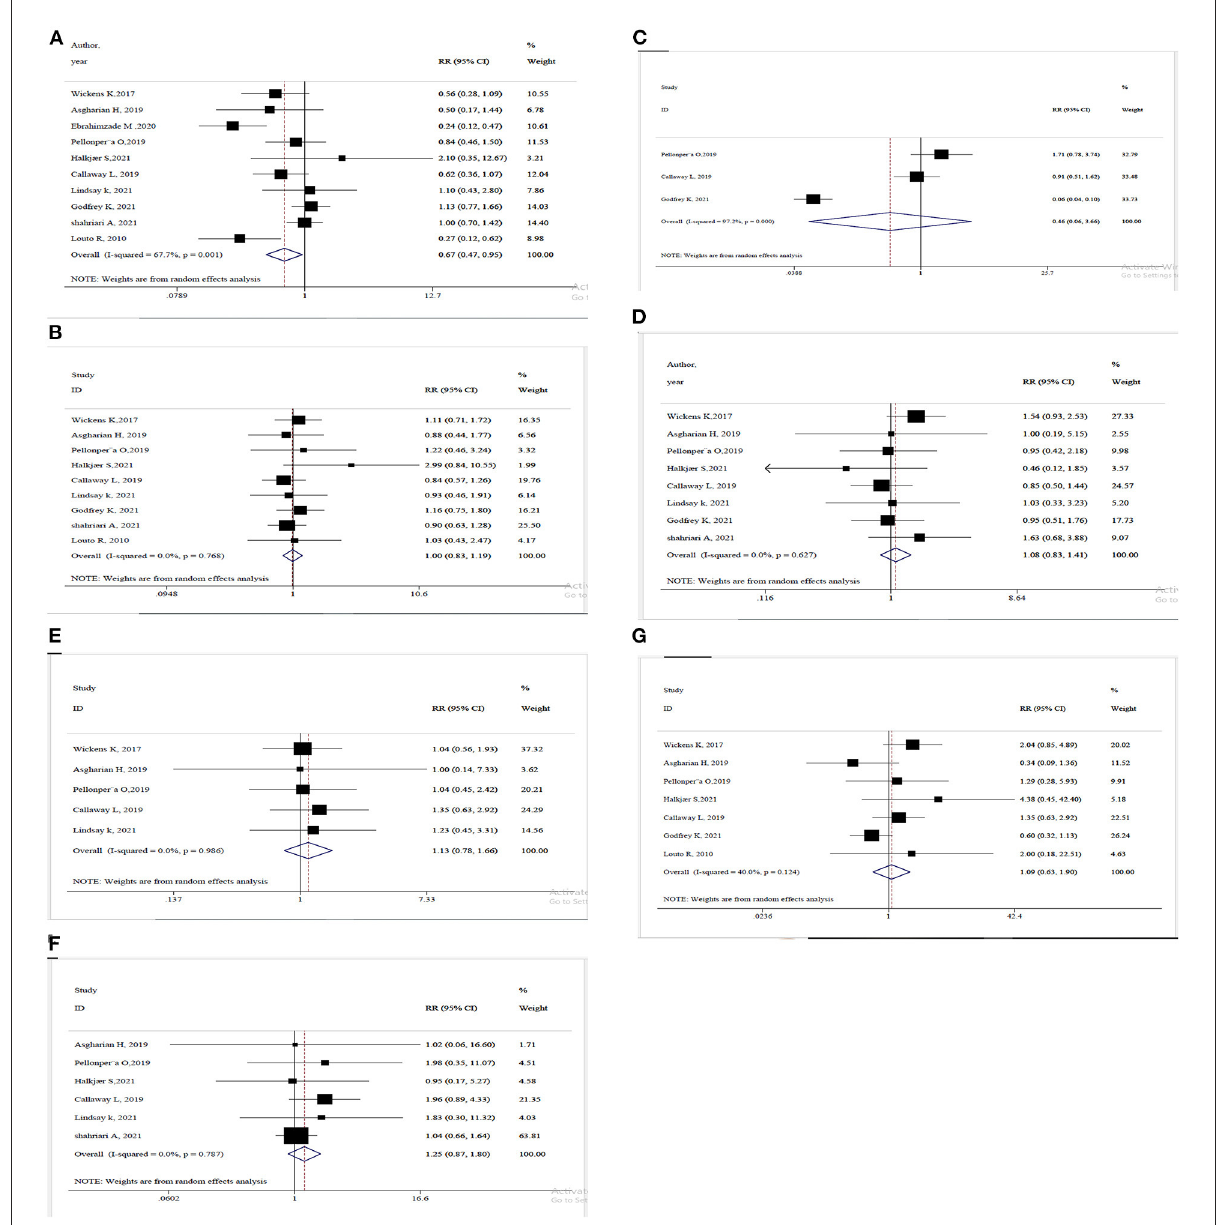
FIGURE2 Forest plot more the meta-analysis of (A) GDM/ (B) Cesarean section/ (C) Hypoglycemia/ (D) Macrosomia/ (E) NICU admission/ (F) Preeclampsia/ (G)